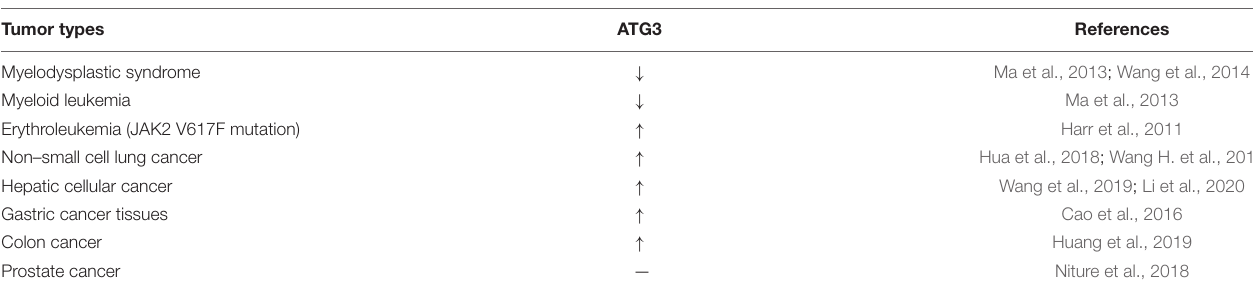
TABLE 2 | Changes of ATG3 in different types of